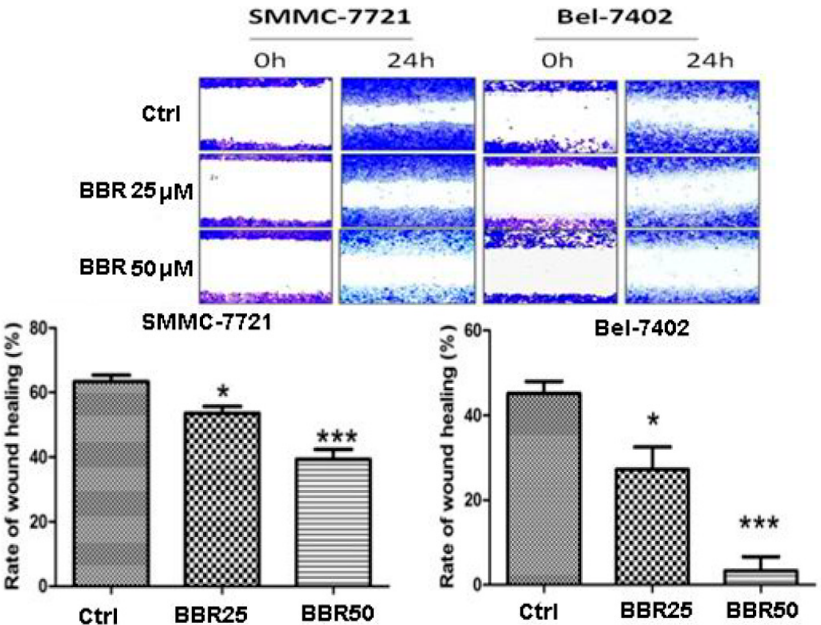
Figure 3. Decreased migration of BBR-treated HCC Cells by wound healing assay. SMMC-7721 and Bel-7402 cells were incubated in 12-well plates with wound healing assay inserts. BBR (25 and 50 μ M) was added for 24 h. The cells were stained by violet crystal and the rate of wound healing was observed and calculated. * p < 0.05 ( vs. the control group); *** p < 0.001( vs. the control group).